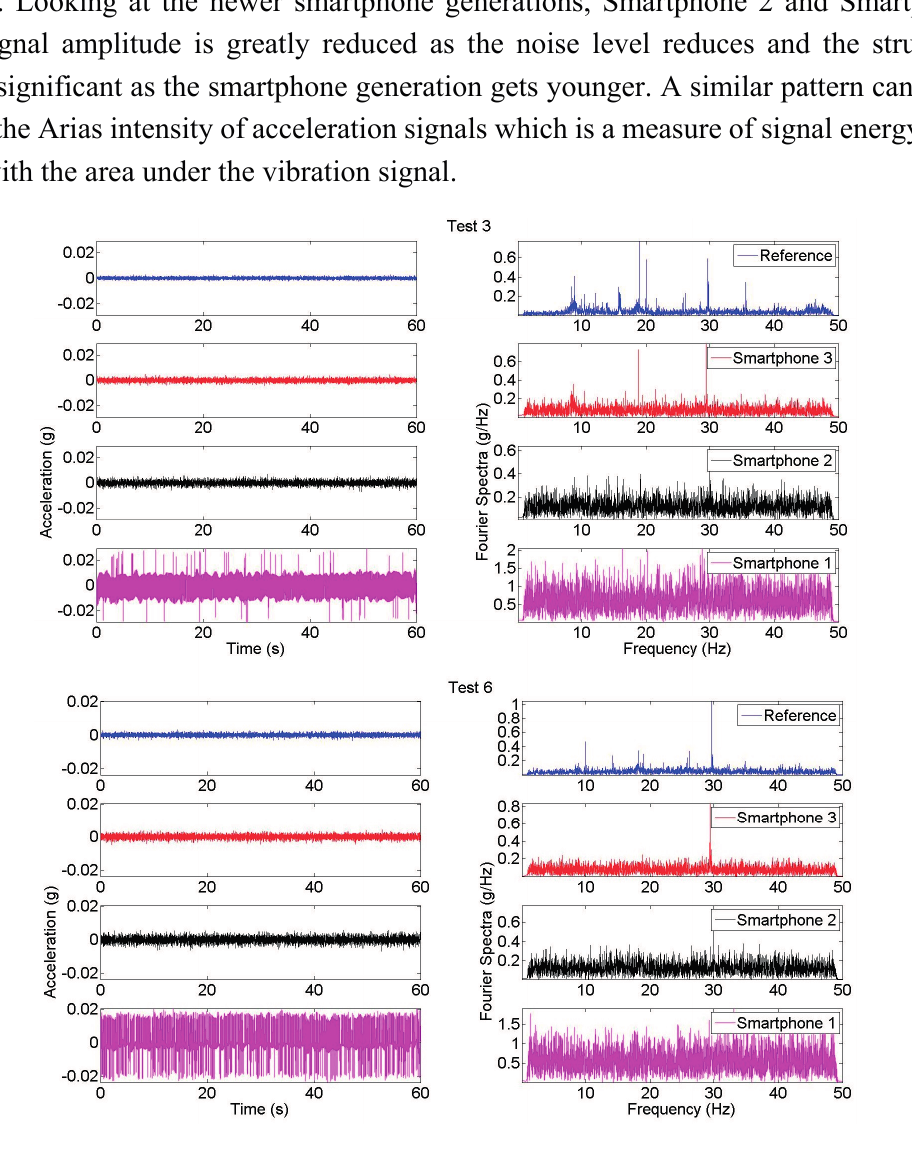
Figure 7. Acceleration time histories and Fourier spectra samples from Test 3 and Test